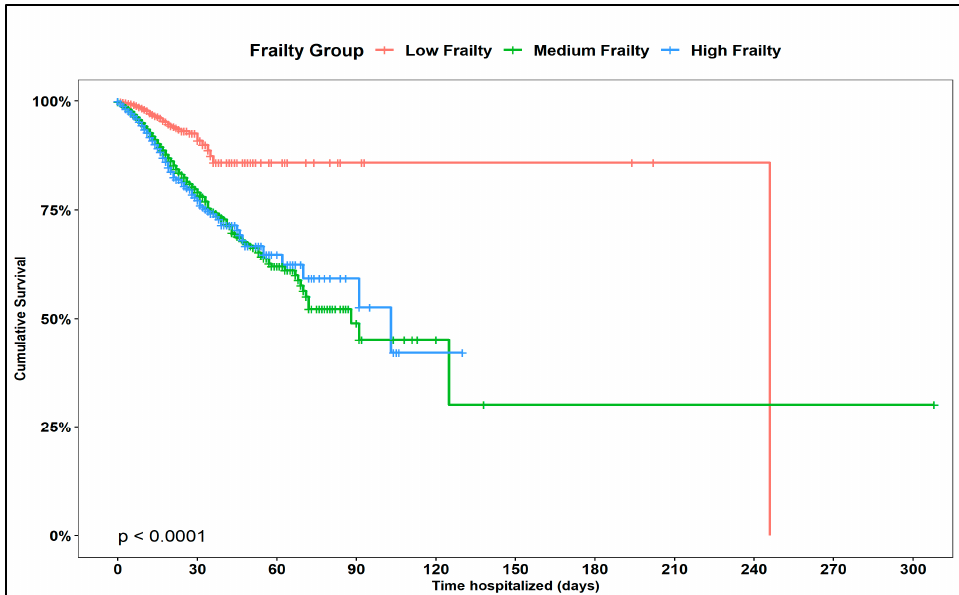
Figure 2. Kaplan ‐ Meier curve estimating the Impact of frailty on inpatient mortality . Figure 2. Kaplan-Meier curve estimating the Impact of frailty on inpatient